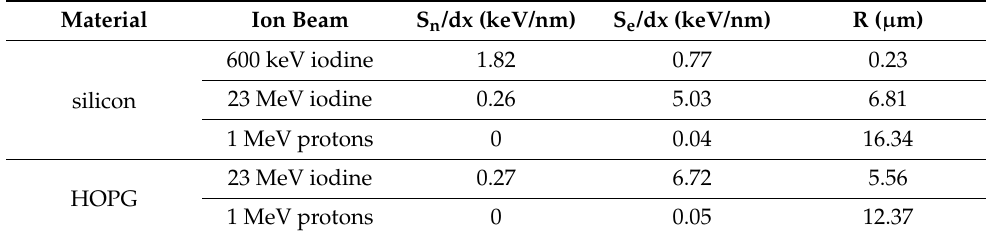
Table 1. Irradiation parameters used in this work: ion type and energy, nuclear energy loss S n /dx, electronic energy loss S e /dx and ion range R, according to the SRIM code [23]. Material Ion Beam S n /dx (keV/nm)